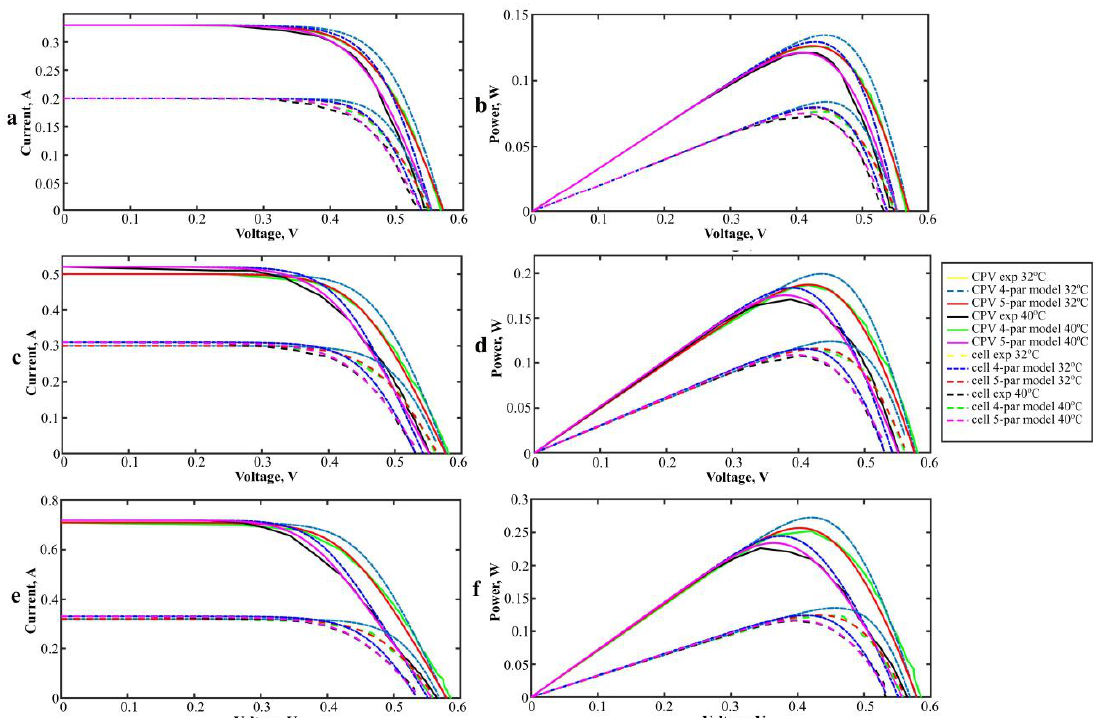
Figure 7. I – V characteristics of solar cell and CPV cell at temperatures of 32 °C and 40 °C for solar radiation level: ( a ) 200 W/m 2 , ( c ) 300 W/m 2 , and ( e ) 400 W/m 2 ; and graphs of output power of solar cell and CPV cell for solar radiation level: ( b ) 200 W/m 2 , ( d ) 300 W/m 2 , and ( f ) 400 W/m 2.